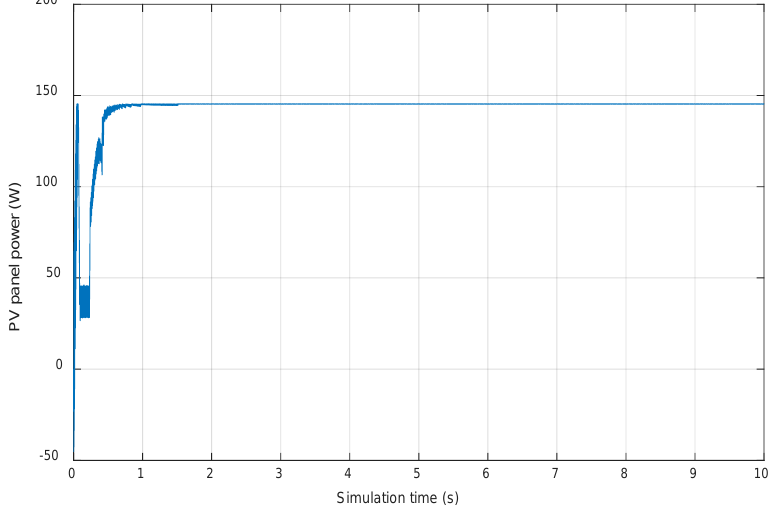
Figure 5. PV modules output power at constant irradiation.